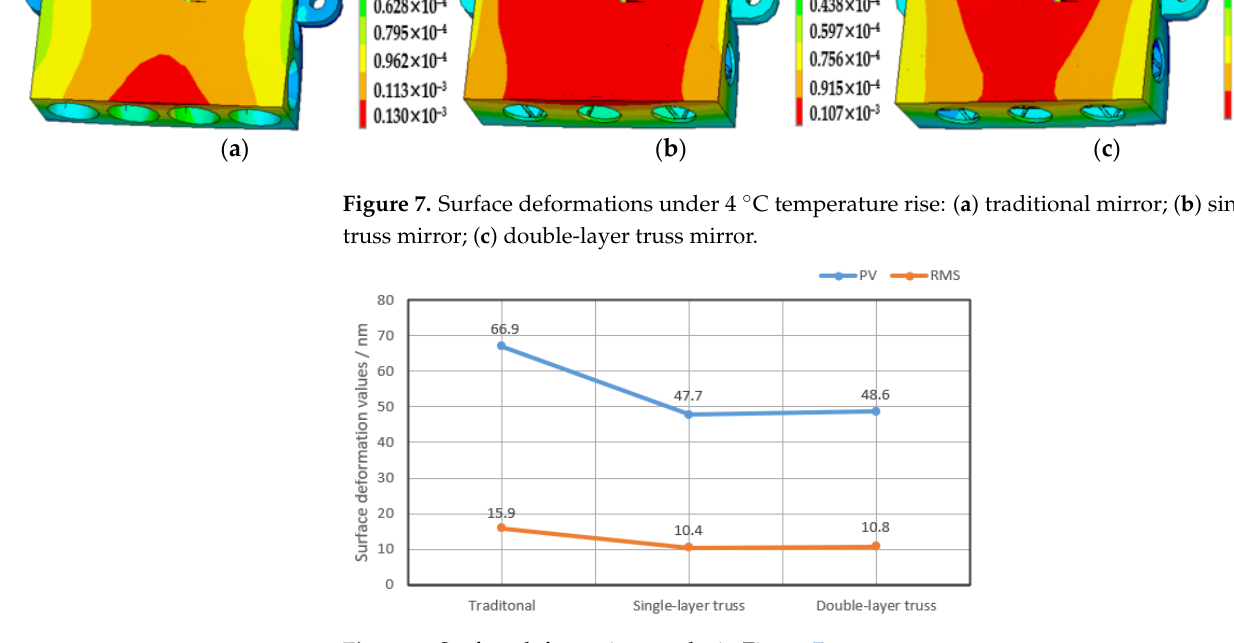
Figure 8. Surface deformation results in Figure 7.